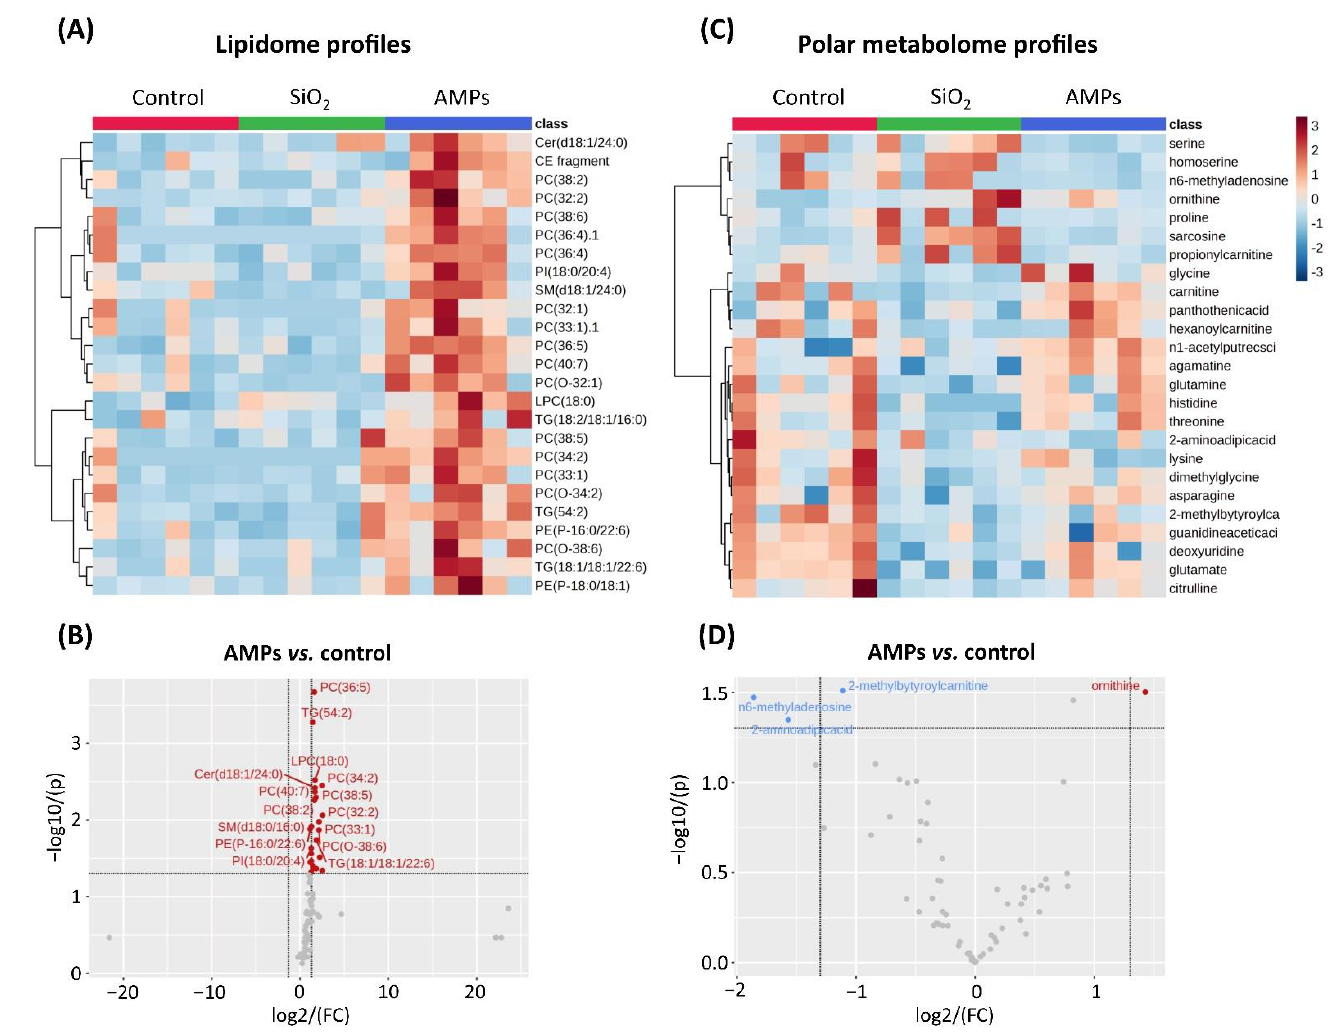
Figure 6. Effects of the (nano)particles unintentionally emitted at the metal AM occupational settings (AMPs) on the lipidome and polar metabolome . The fold changes (blue and red) of the top 25 out of 73 identified lipids, via the untargeted lipidomics ( A ) and the top 25 out of 63 identified polar metabolites, via the targeted metabolomics ( C ) are represented as feature-clustered heatmaps. Each column within the heatmaps represents one of three biological replicates with two technical repetitions. SiO 2 was used as a positive control. Volcano plots show the up-regulation (red) or down-regulation (blue) of the lipids ( B ) and polar metabolites ( D ) after 24 h of exposure to 25 μg/mL AMPs. The log2 (FC — fold change) of the relative abundance of the lipids/polar metabolites in the AMP-exposed cells and in the control cells. The y -axis represents the − log10 ( p -value) between the exposed and control samples. Results reported in the volcano plots ( B , D ) are a summary of three biological replicates with two technical repetitions.